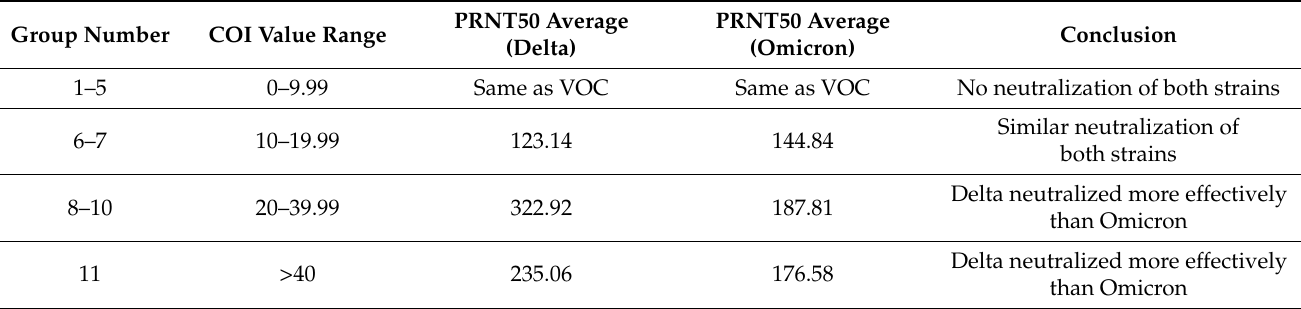
Table 3. Average PRNT50 values obtained for different COI groups when challenged with the delta or omicron variant.